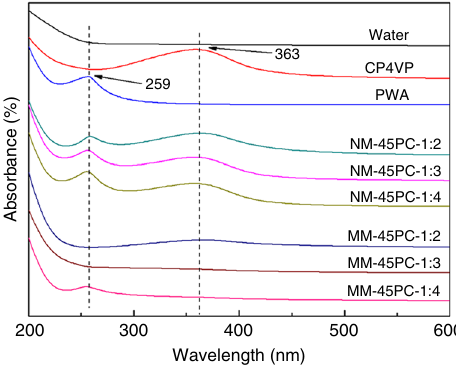
Fig. 3 Ultraviolet – visible spectral analysis of leach water for various membranes. Among all composite membranes with various CP4VP/PWA ratios, only MM-45PC-1:3 shows no PC leakage (dashed lines are used to guide the eyes). CP4VP: ferrocyanide-coordinated poly(4-vinylpyridine); PWA: phosphotungstic acid; NM-45PC: normal-cast membrane with 45wt% loading of proton-conducting components; MM-45PC: magnetic-cast membrane with 45wt% loading of proton-conducting components; PC: proton-conducting components. Source data are provided as a Source Data fi